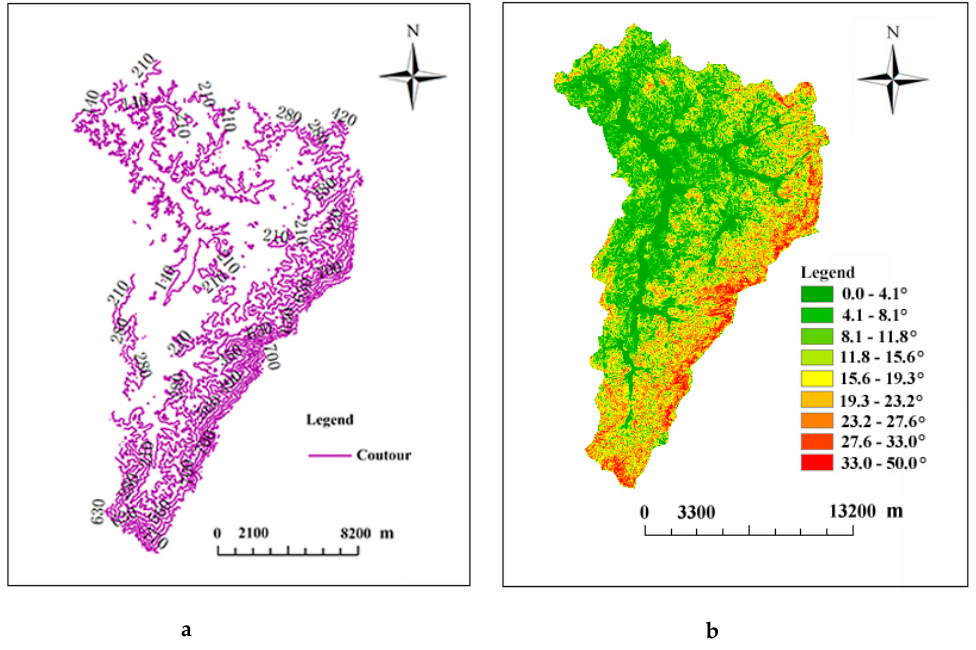
Figure A1. Watershed characteristics: ( a ) watershed elevation, and ( b ) watershed slope.